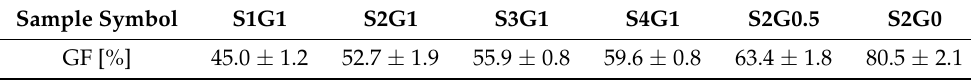
Table 1. Effect of hydrogel composition on gel fraction (GF%) ( n =